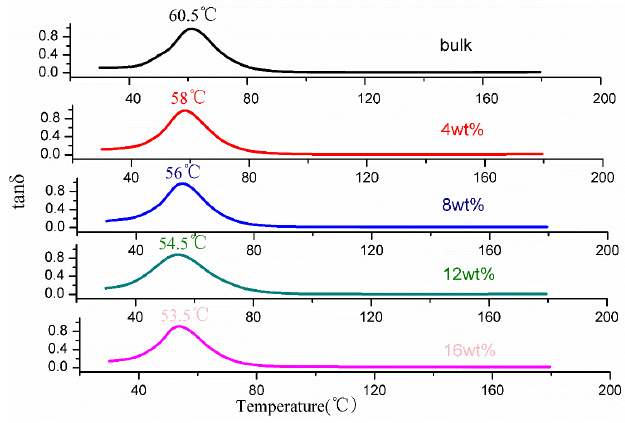
Figure 5. Tan δ curves of SiCw/hydro-epoxy composites. Appl. Sci. 2017 , 7 , 108